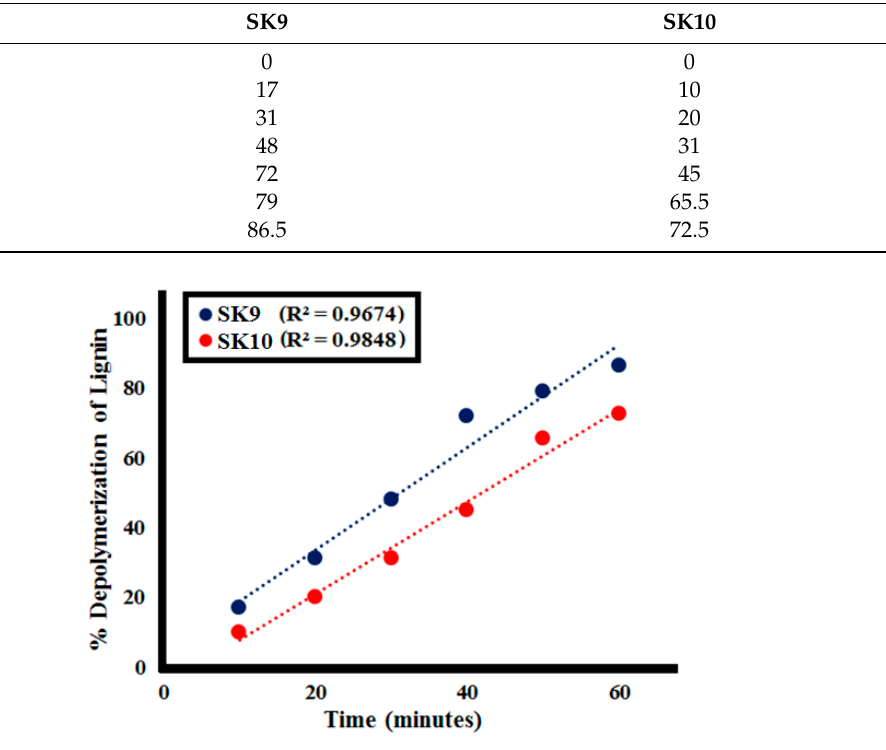
Figure 8. Correlation between the %depolymerization of lignin ( L1 100ppm ) by SK9 (0.1 g) and SK10 (0.1 g) and the time